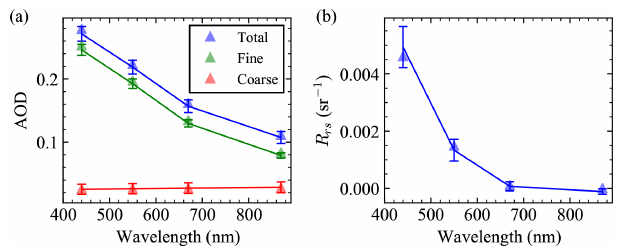
Figure 4. Example of AOD (solid line) and R rs spectra retrieved from one case of synthetic HARP2 measurements as shown in Fig. 2b and c with retrieval uncertainties indicated by the error bar. The triangles indicate truth values. Chl a for this case is 0.1mgm − 3